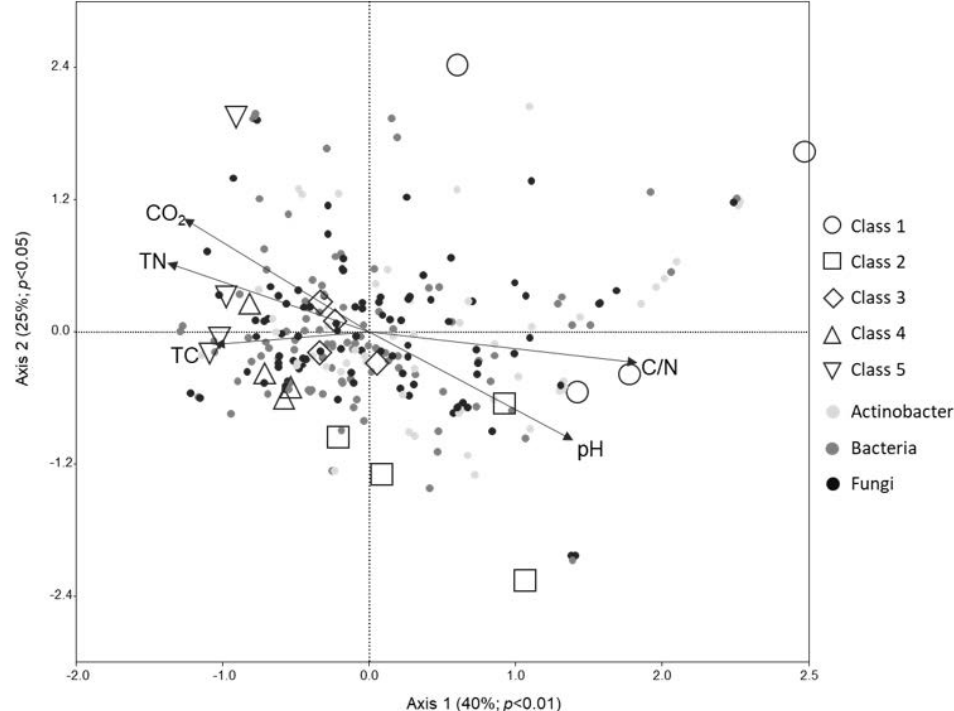
Figure 3. Canonical correspondence analysis (CCA) ordination diagram of microbial communities and environmental variables defined by the first and second axes. The percentage of variation in the data and significance is reported at each axis. The plots were generated by actinobacterial 16S rDNA gene (light grey dots), bacterial 16S rDNA gene (grey dots), and 18S rDNA gene (dark grey dots) DGGE banding patterns. Vectors represent deadwood pH; deadwood total C content (TC); deadwood total N content (TN); deadwood C/N ratio; and CO 2 flux from deadwood